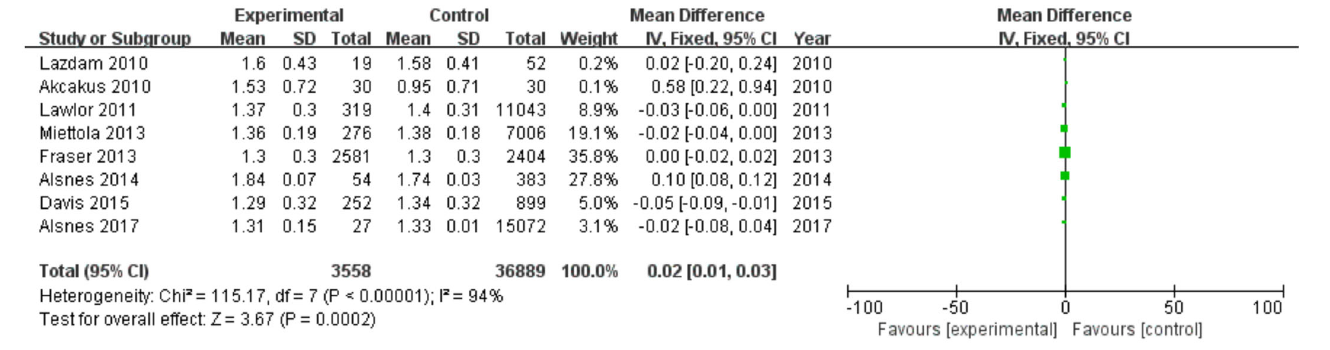
Figure 6. Meta-analysis forest map for diastolic blood pressure of offspring of PE pregnancies. Figure 6. Meta ‐ analysis forest map for high ‐ density lipoprotein cholesterol of offspring of PE preg ‐